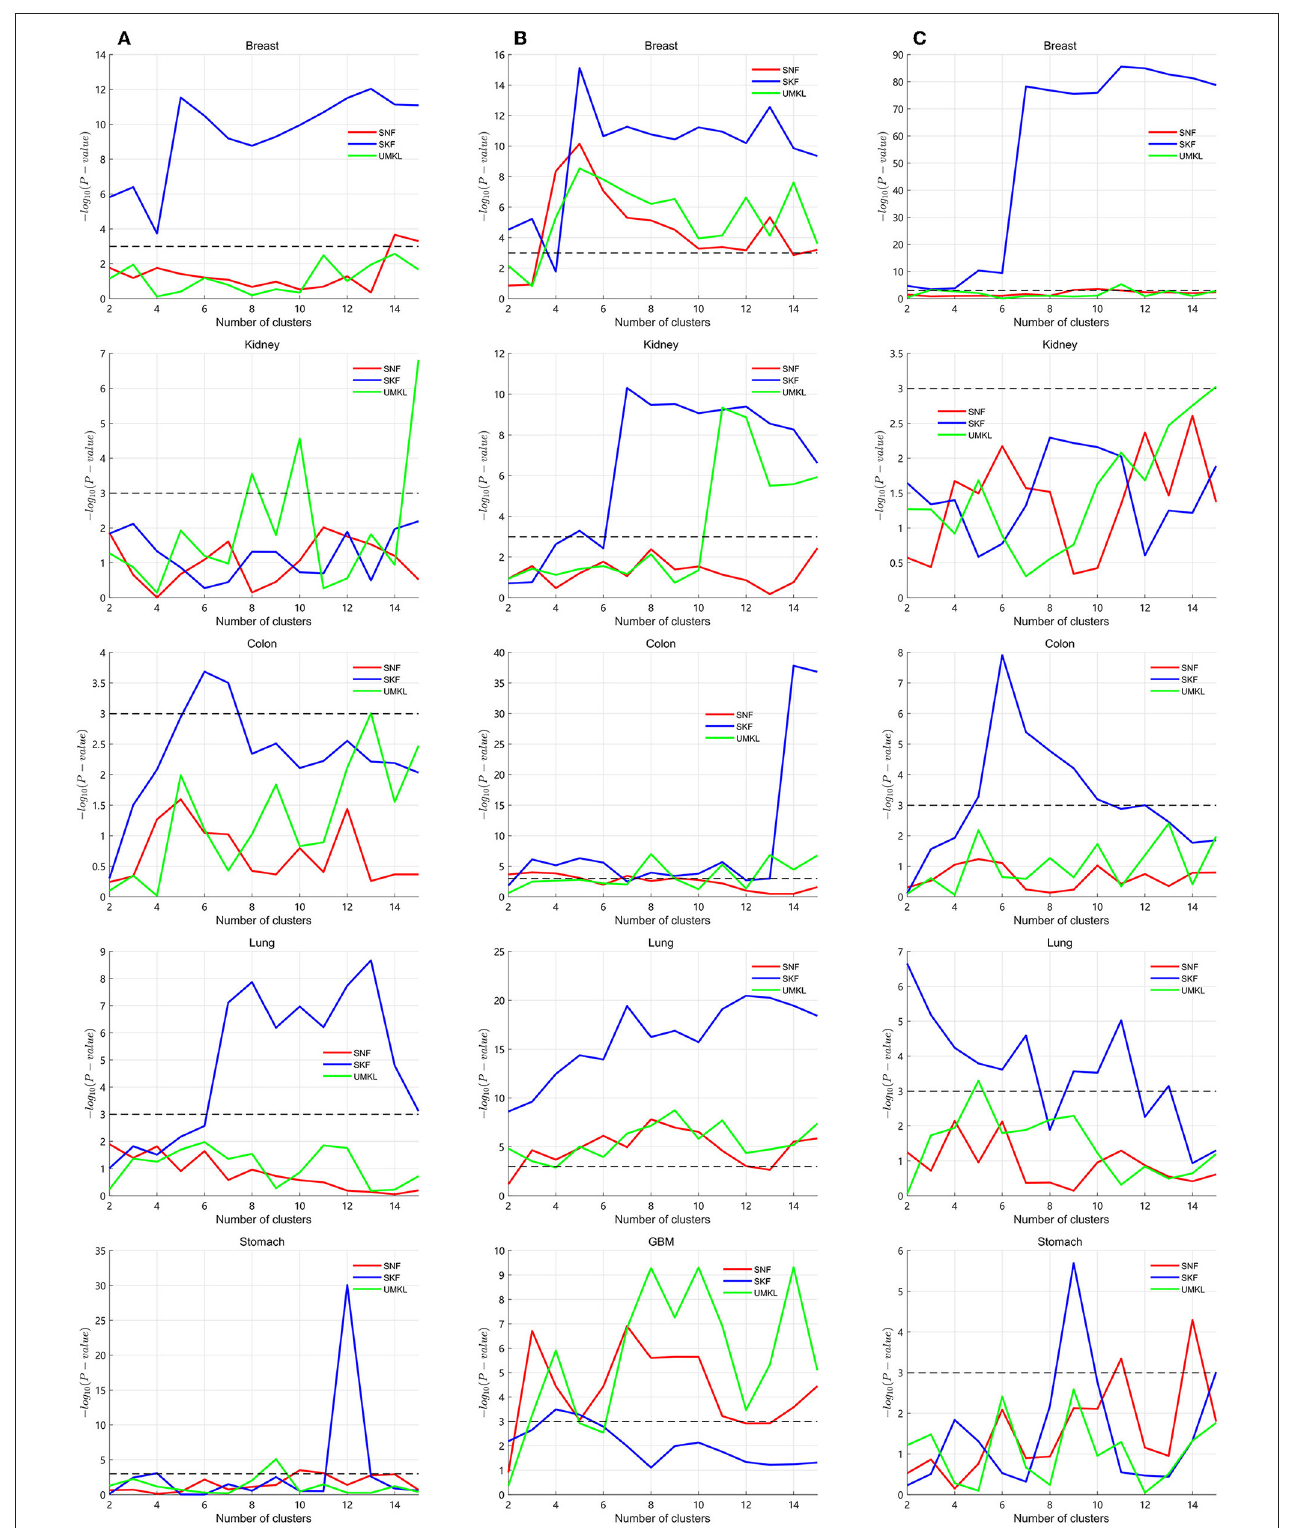
FIGURE 3 | Calculating P -values of SKF, SNF, and UMKL with different number of clusters. (A) Results of Dataset No.1. (B) Results of Dataset No.2. (C) Results of Dataset No.3.